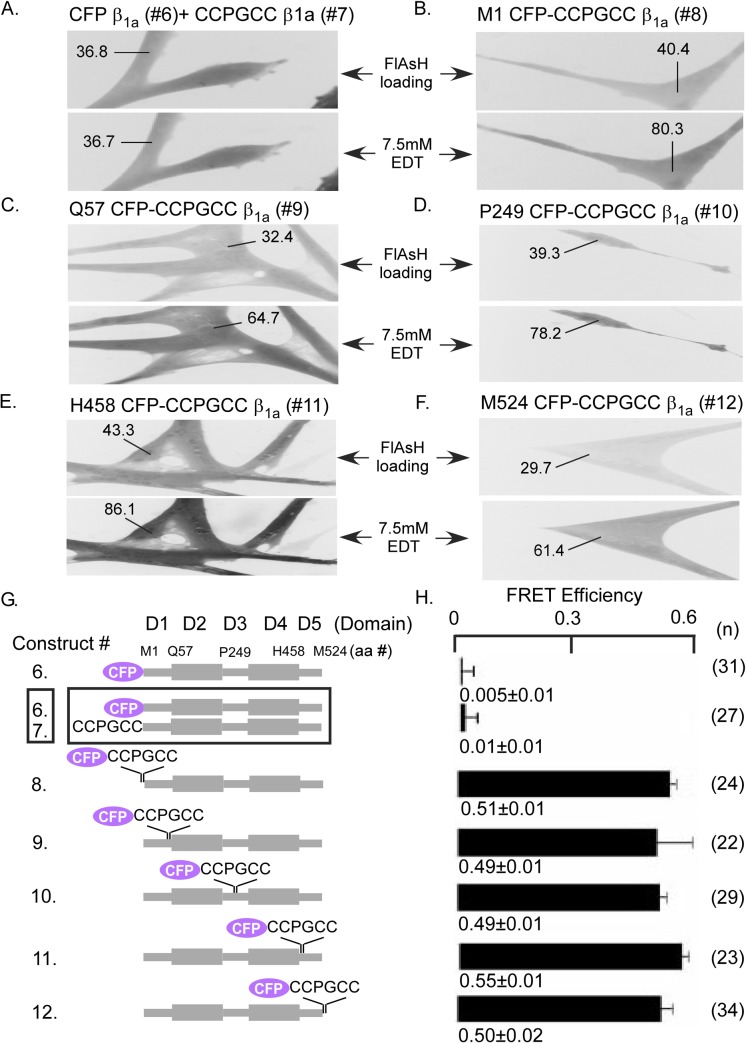
FRET signals from ß1a subunits incorporating the CFP-CCPGCC concatamer in different domains or doubly transfected CFP and CCPGCC tags expressed in WT myotubes.(A) Myotubes co-transfected with CFP- ß1a (construct 6) and CCPGCC- ß1a (construct 7), constructs demonstrate unchanged FRET efficiency after FlAsH clearance with 7.5 mM EDT indicating that ß1a intermolecular interactions do not contribute to FRET in the present study. Myotubes individually transfected with the CFP-CCPGCC concatemers (B) M1 CFP-CCPGCC ß1a (construct 8), (C) Q57 CFP-CCPGCC ß1a (construct 9), (D) P249 CFP-CCPGCC ß1a (construct 10), (E) H458 CFP-CCPGCC ß1a (construct 11) or (F) M524 CFP-CCPGCC ß1a (construct 12) show ~2 fold FRET efficiency after FlAsH clearance with 7.5mM EDT. The numbers indicated represents the fluorescence intensity of the region in the myotubes before and after FlAsH clearance with EDT for FRET measurements. (G) Schematic diagrams of tagged ß1a constructs (constructs 6 to 12) that were used to assess the accessibility of FlAsH to tertracycteine tags incorporated in different domain of ß1a. (H) Comparison of the FRET efficiencies for different ß1a constructs (constructs 6 to 12) expressed in WT myotubes that shows in panel A to G with number of tested cells for each group in parentheses. Mean FRET efficiencies ± standard errors are shown.